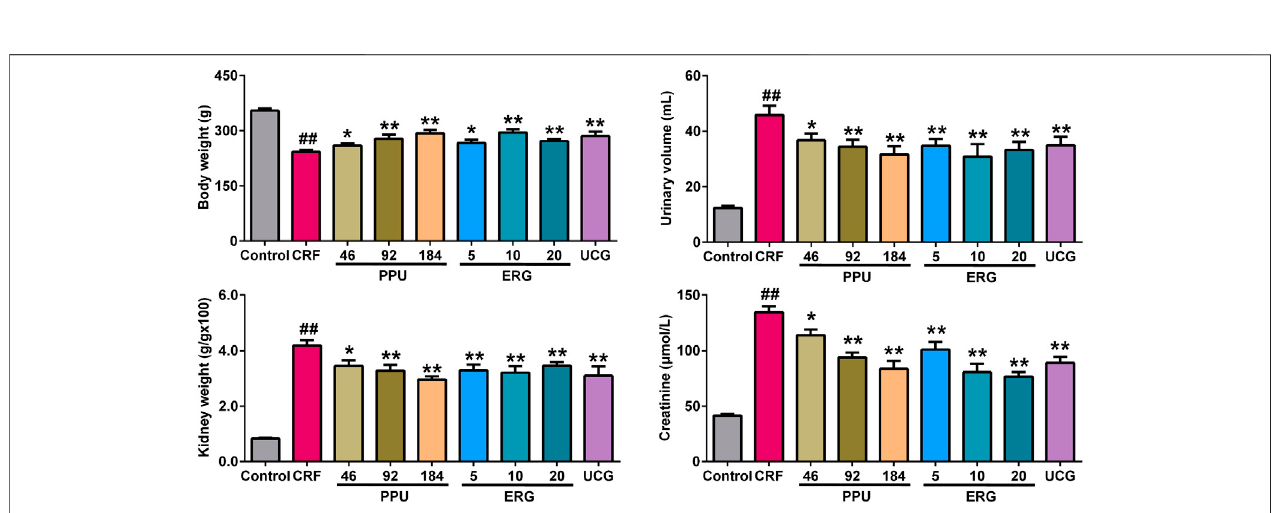
FIGURE 5 | Treatment with PPU and ergone improved impaired renal function. Body weight, urine volume, kidney weight index and serum creatinine levels in the control, CRF, CRF + PPU and CRF + ERG groups. ## p < 0.01 compared with control group, *p < 0.05, ** p < 0.01 compared with CRF group.